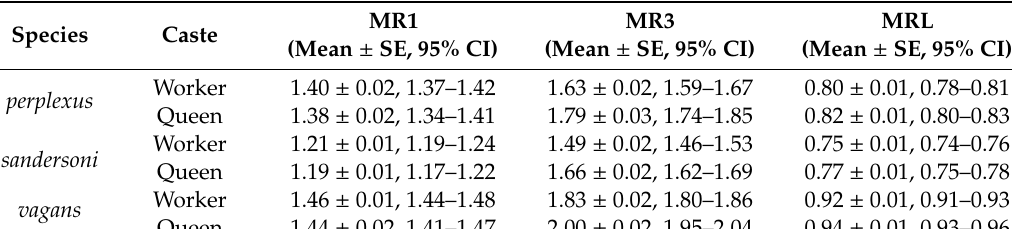
Table 2. Estimated means from the linear model for the three malar ratio measurements and among the three species for both workers and queens. Results are averaged over the two levels of region.